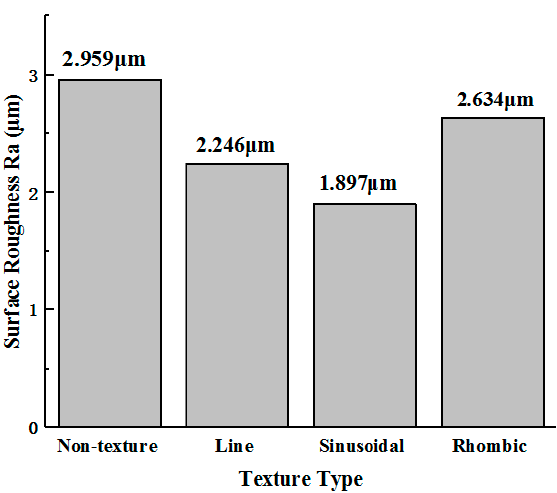
= 90.4 m / min, a = 0.4 p